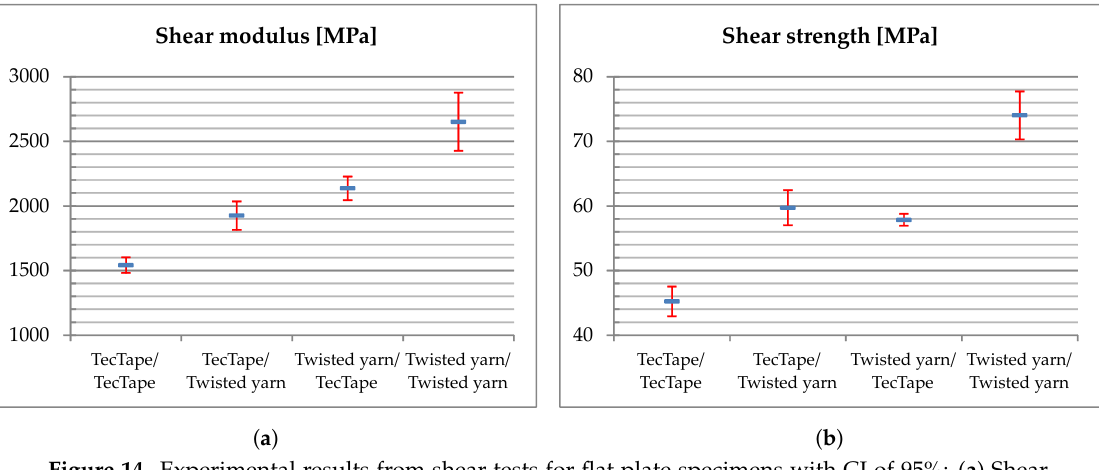
Figure 14. Experimental results from shear tests for flat plate specimens with CI of 95%: ( a ) Shear modulus. ( b ) Shear strength. Table 4. Experimental results from shear tests for flat plate specimens with CI of